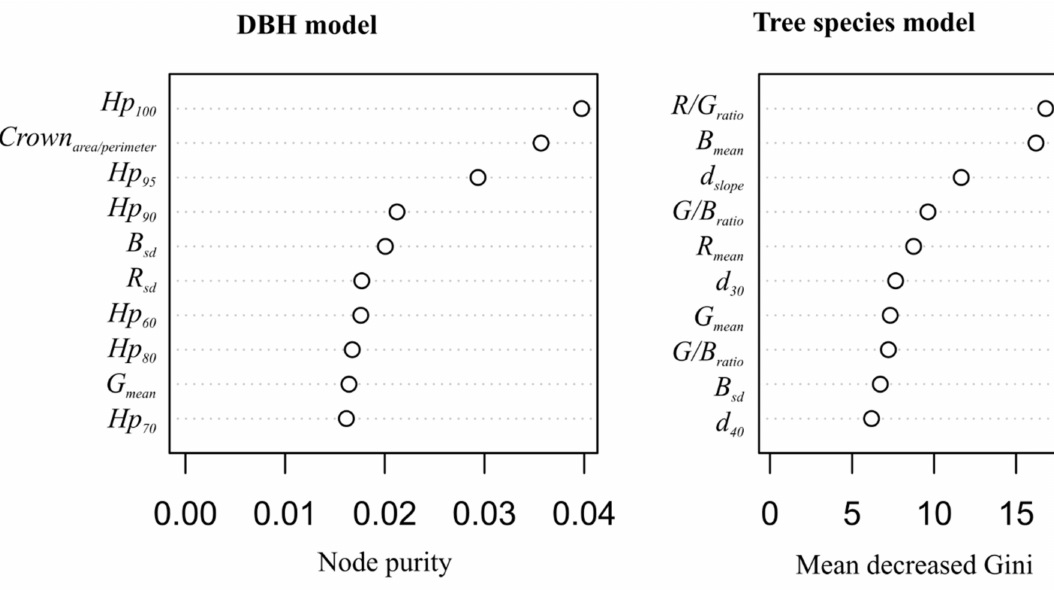
Figure 5. Variable importance plot, including the ten most important variables for the Random Forests models for DBH and tree species.